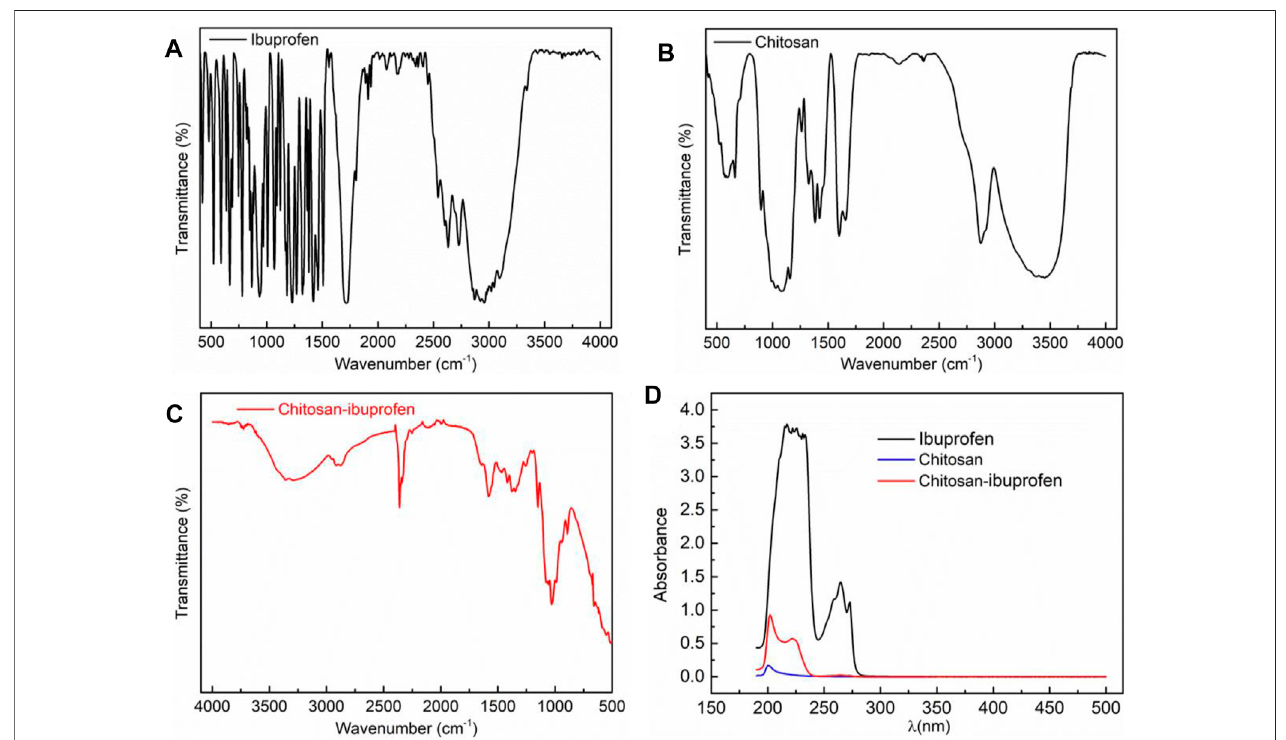
FIGURE 3 | FTIR spectra of ibuprofen (A) , chitosan (B) , and chitosan – ibuprofen aerogels (C) ; UV-Vis spectra of ibuprofen, chitosan, and chitosan – ibuprofen aerogels (D) .